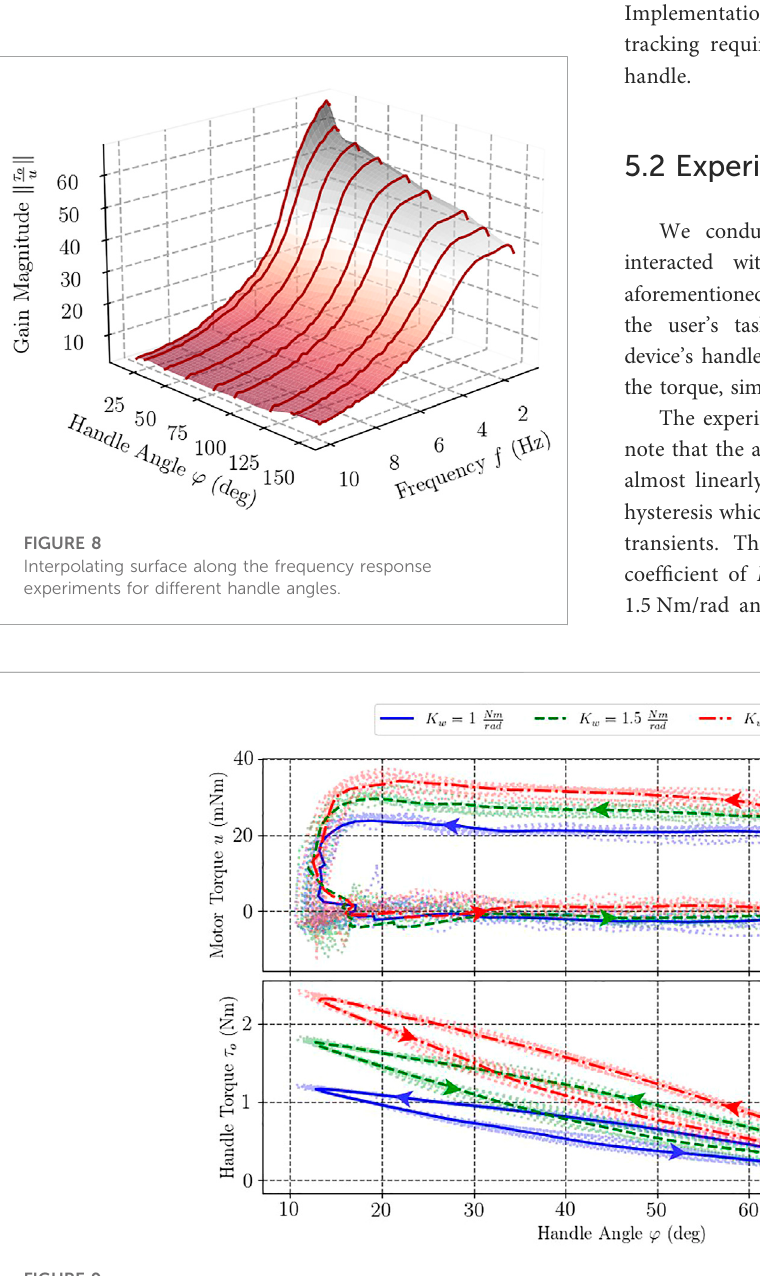
Frontiers in Robotics and